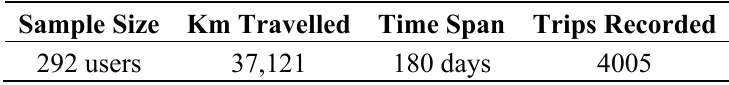
Table 1. Data set descriptive